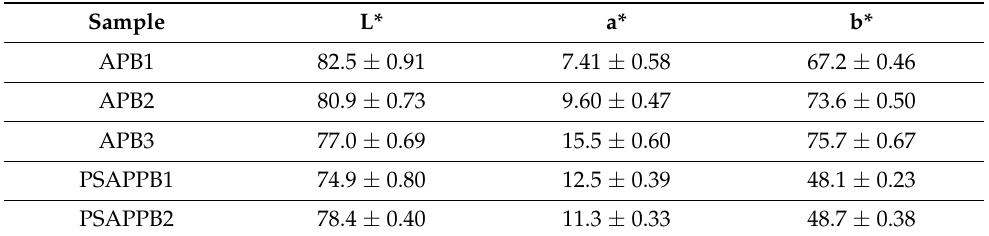
Table 3. Average values and standard deviation of the chromatic coordinates of yellow samples.